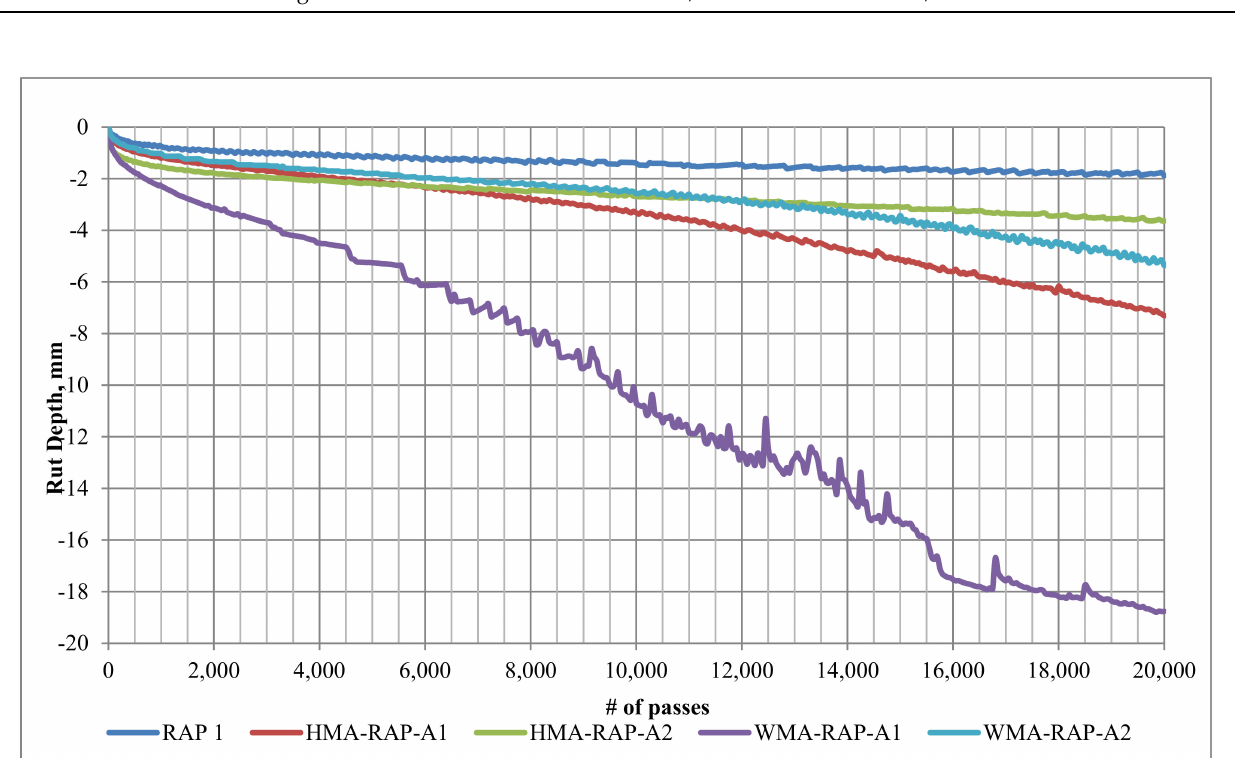
Figure 7. Average test results of the Hamburg wheel tracking test for all mixture